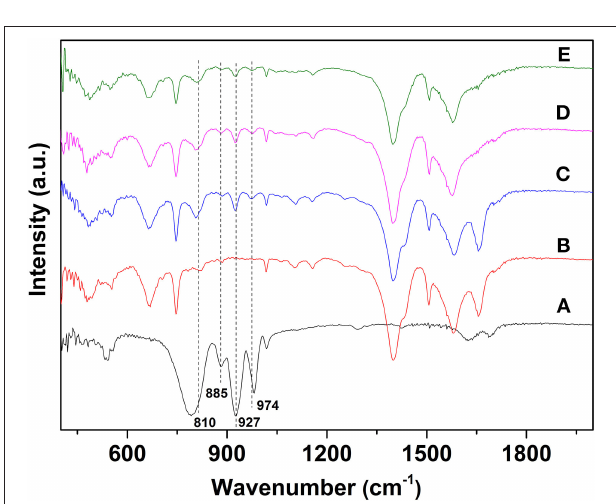
FIGURE 3 | FTIR spectra of SiW (A) , UiO − 66 (B) , 11.7% SiW@UiO − 66 (C) , 2.0% Ru/11.7% SiW@UiO − 66 (D) , and the used 2.0% Ru/11.7% SiW@UiO − 66 catalyst (E)